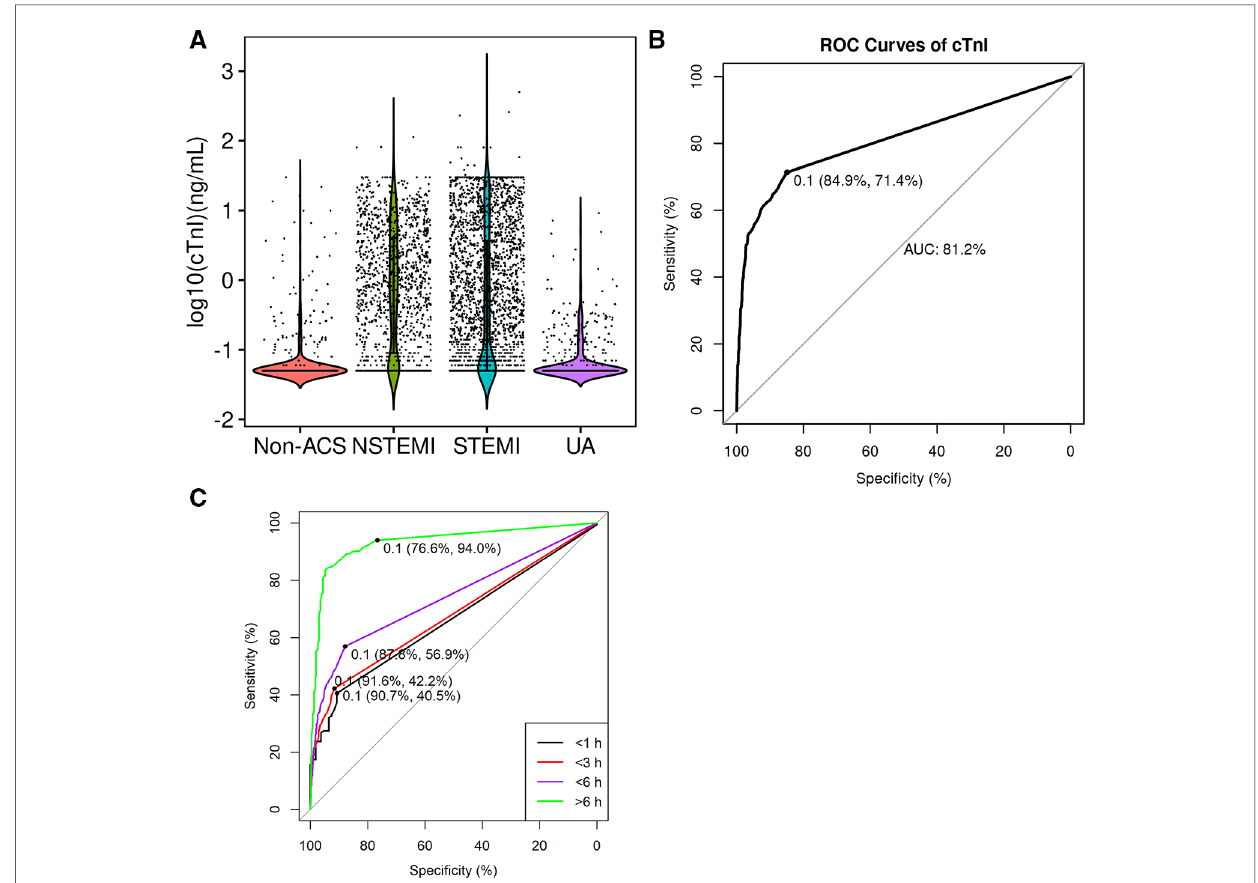
FIGURE 2 ROC curve of cTnI for AMI diagnosis. ( A ) Violin plot of point-of-care cTnI concentration levels in different groups of patients; ( B ) ROC curve of cTnI for AMI diagnosis in all patients; ( C ) ROC curve of cTnI for AMI diagnosis in different time points. STEMI, ST-segment elevation myocardial infarction; NSTEMI, non-ST-elevation myocardial infarction; UA, unstable angina pectoris; AMI, acute myocardial